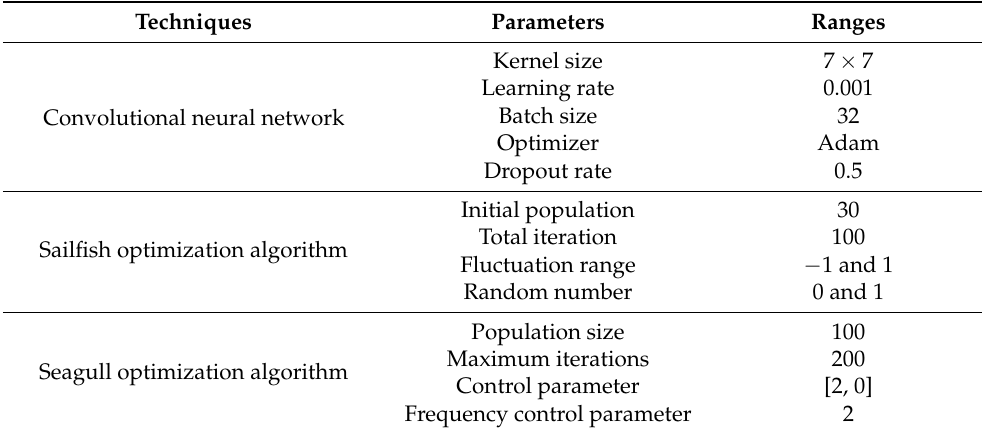
Table 2. Parameter